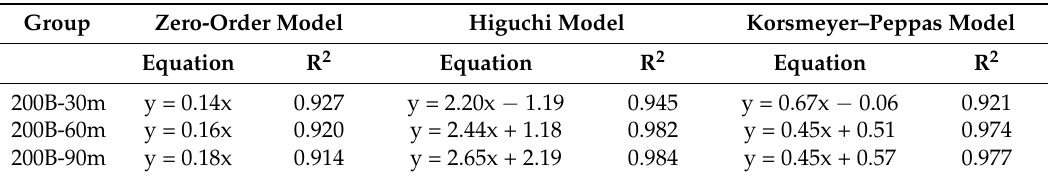
Table 2. Determination of the coefficient (R 2 ) of the fitted model equations applied to the thymol release kinetics.